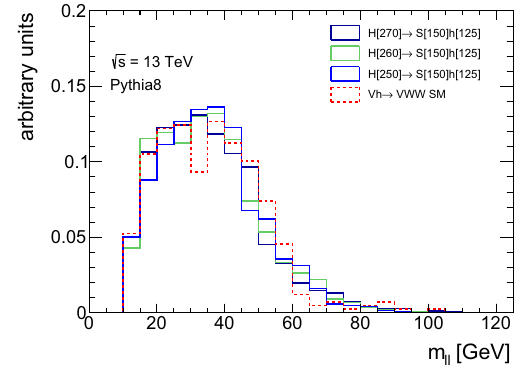
Fig. 2 Di-lepton invariant mass for several H → Sh samples (solid lines) compared with the SM Vh process with h → WW (dashed line) generated with PYTHIA8